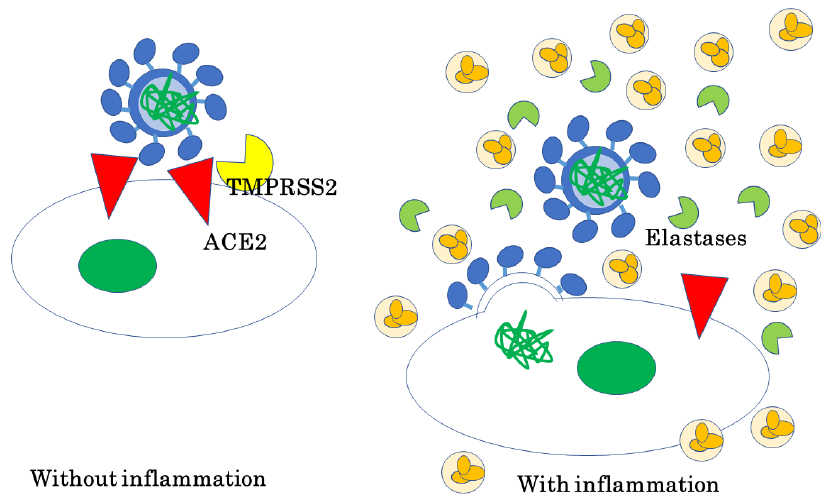
Figure 3. SARS-CoV-2 and SARS-CoV utilize ACE2 as their receptor with no inflammation, while they utilize abundant environmental elastases with inflammatory condition to enter cells.